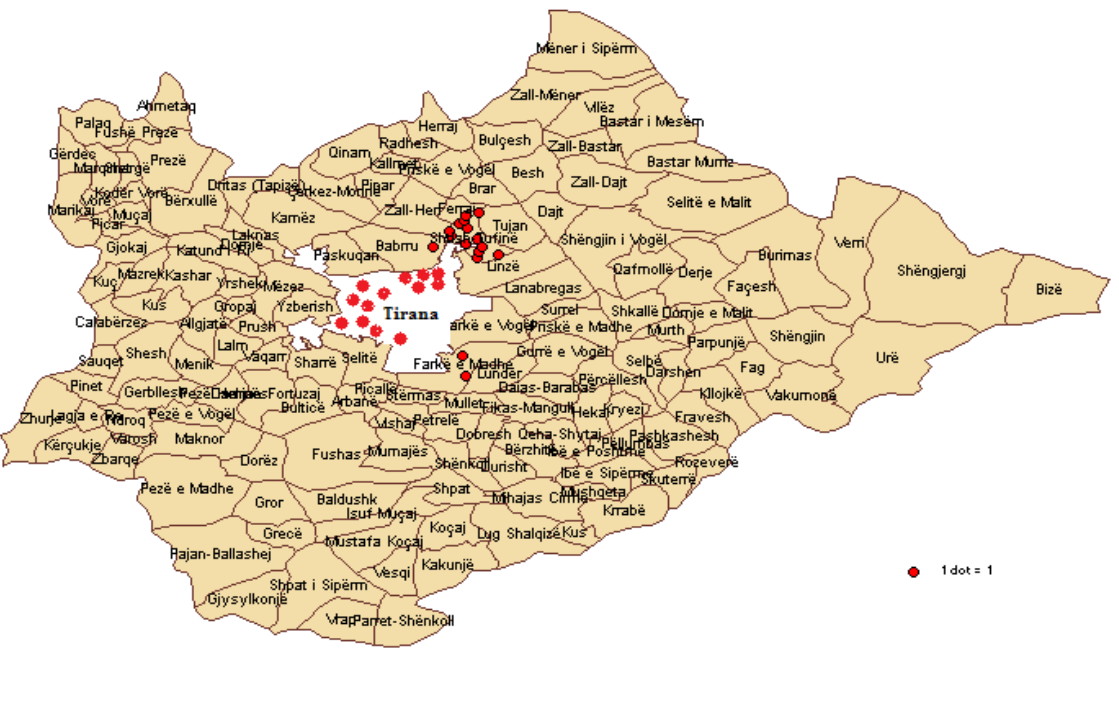
Figure 1. Distribution of HBV cases by area in Tirana